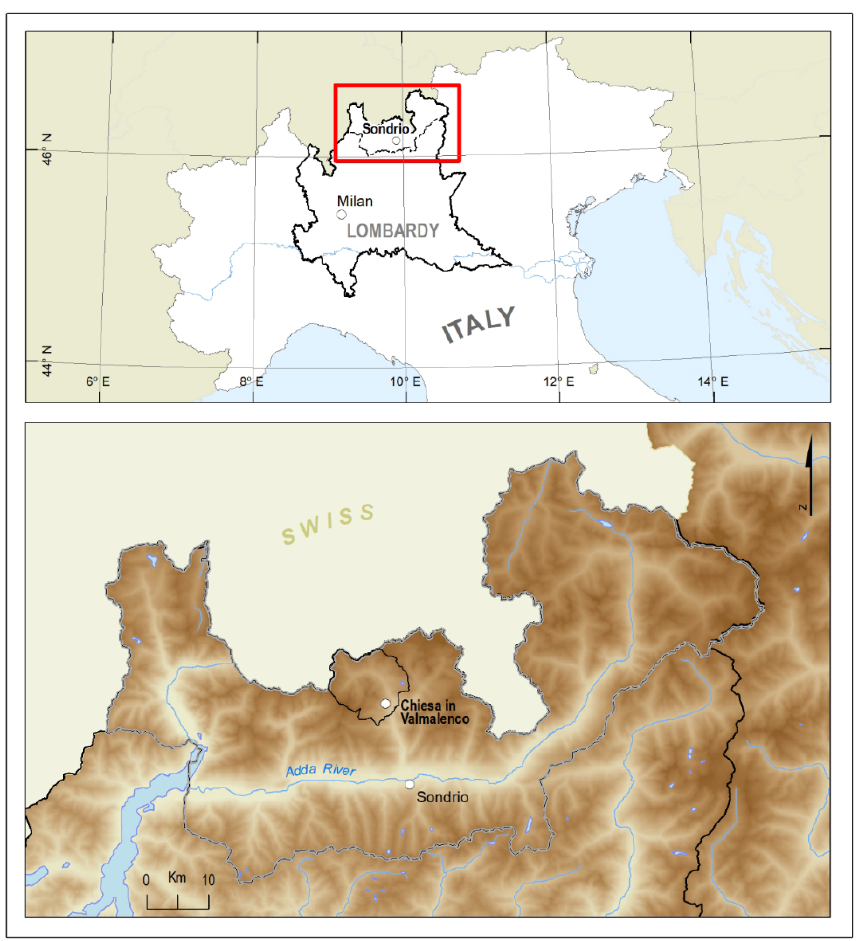
Figure 1. Geographical position of Chiesa in Valmalenco (Sondrio, Lombardy, Northern Italy). Original map by L. Dell’Olmo, University of Florence.